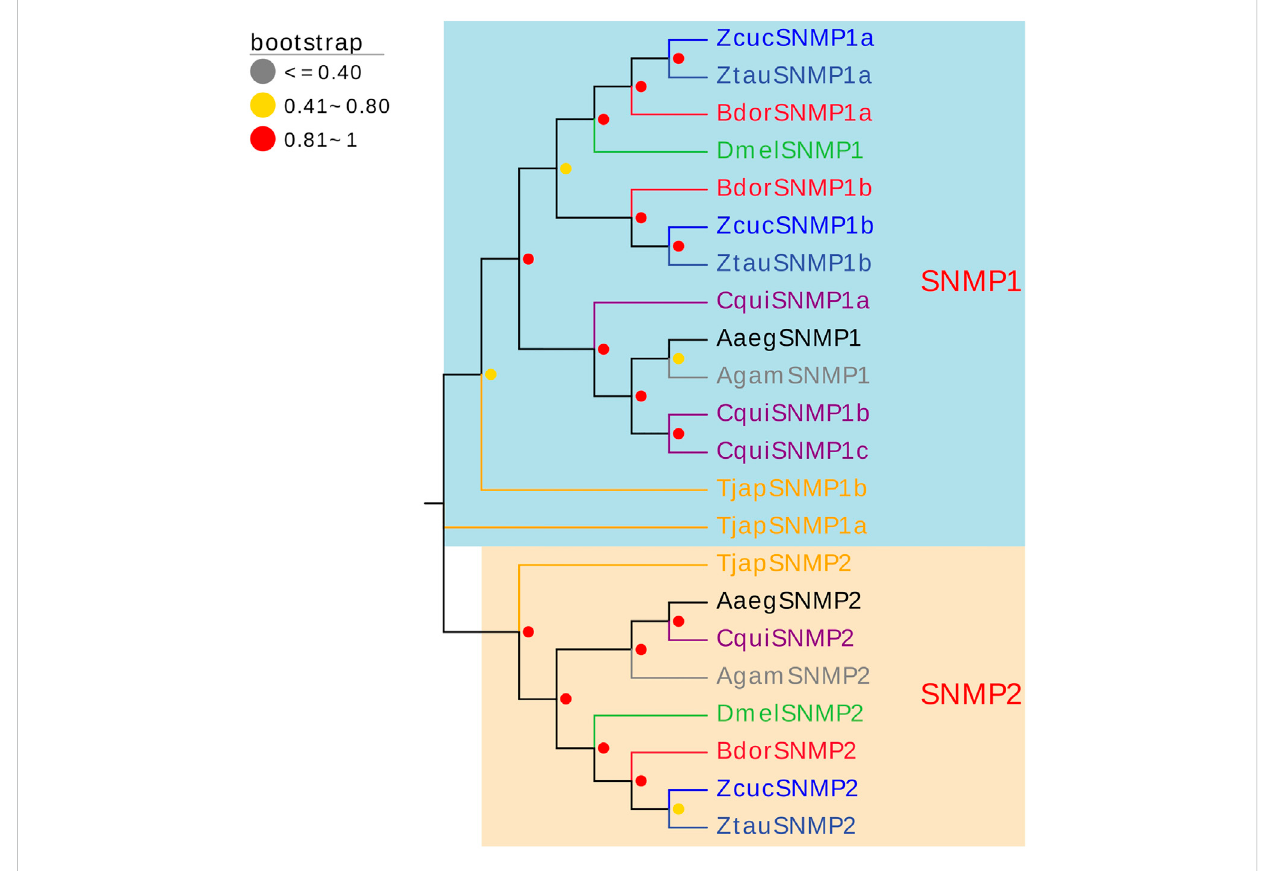
FIGURE 6 The NJ phylogenetic analysis of SNMPs in T. japonensis , A. aegypti , A. gambiae , B. dorsalis , C. quinquefasciatus , Zeugodacus tau , Z. cucurbitae , and D. melanogaster . The SNMP1 group and SNMP2 group are shown.